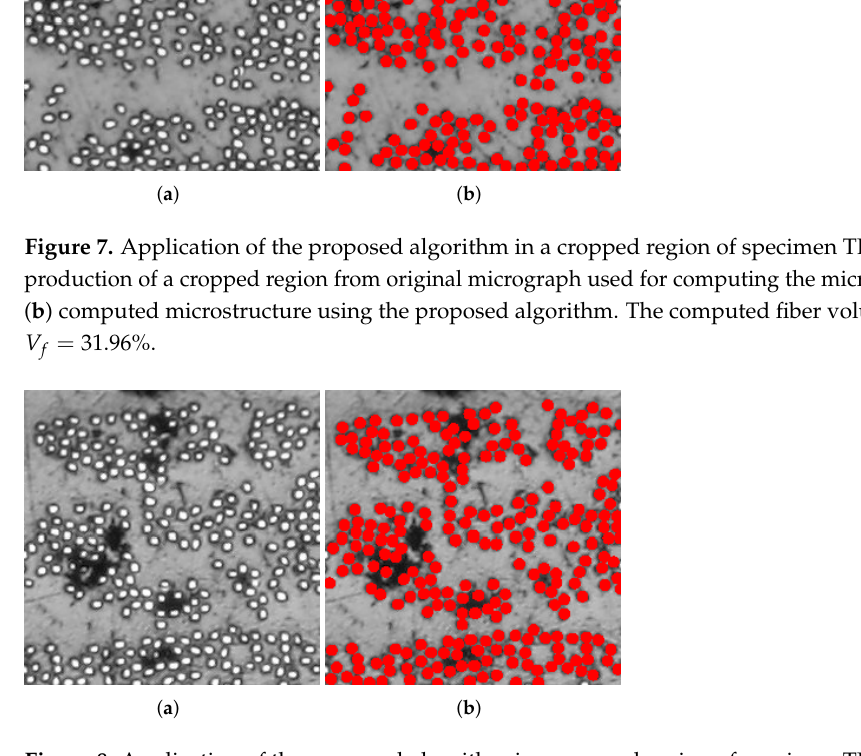
Figure 8. Application of the proposed algorithm in a cropped region of specimen TE-90-4-2: ( a ) re- production of a cropped region from original micrograph used for computing the microstructure and ( b ) computed microstructure using the proposed algorithm. The computed fiber volume fraction is V f =